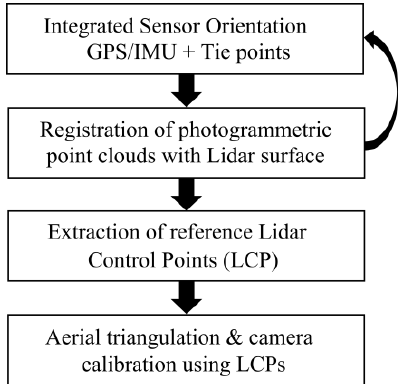
Figure 1: Main steps of the research